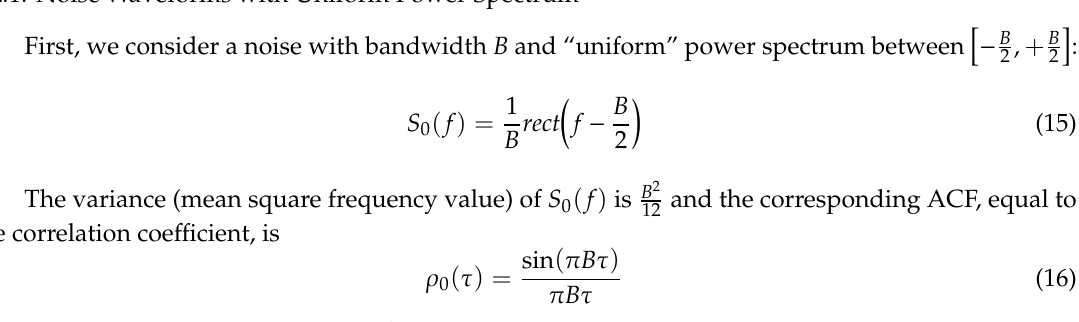
Figure 4. Parameter (cid:1837) (dB), as defined in Equation (2), versus (cid:2012) with BT varying, Equation (14).